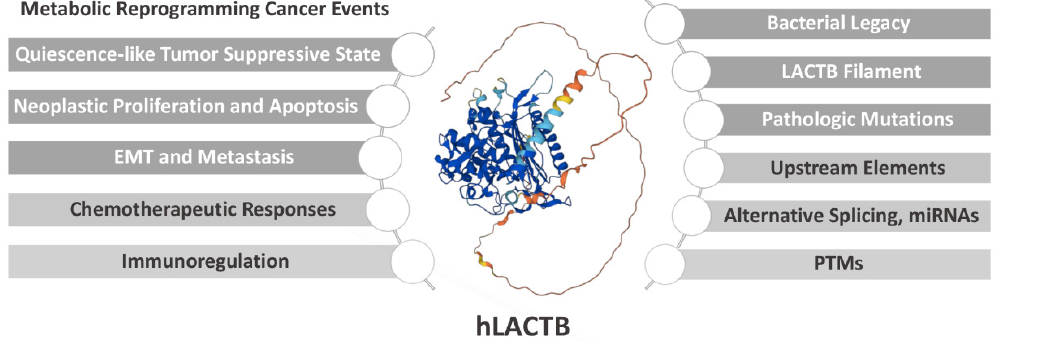
Figure 1. The frame of the perspective. The roles of LACTB in metabolic reprogramming cancer evets have been reviewed in the perspective. Moreover, the structural basis for its enzymatic function as well as the upstream regulation at transcriptional, post-transcriptional, and post-translational levels are elucidated further. The image of hLACTB is obtained by AlphaFold Protein Structure Database [6]. hLACTB, human LACTB; PTMs, post-translational modifications.